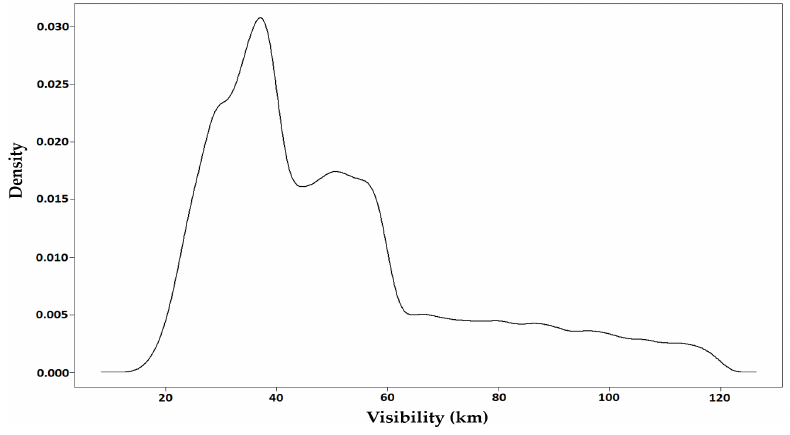
Figure 9. Marginal kernel density of visibility estimated using all ( ≈ 80 thousand) measurements from the image-based method. A bandwidth of 1.56 is used as a parameter for kernel density